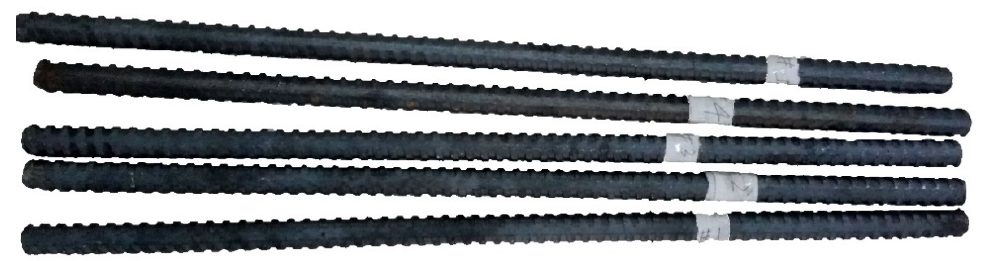
Figure 12. Rebar bolt used in the experiment.